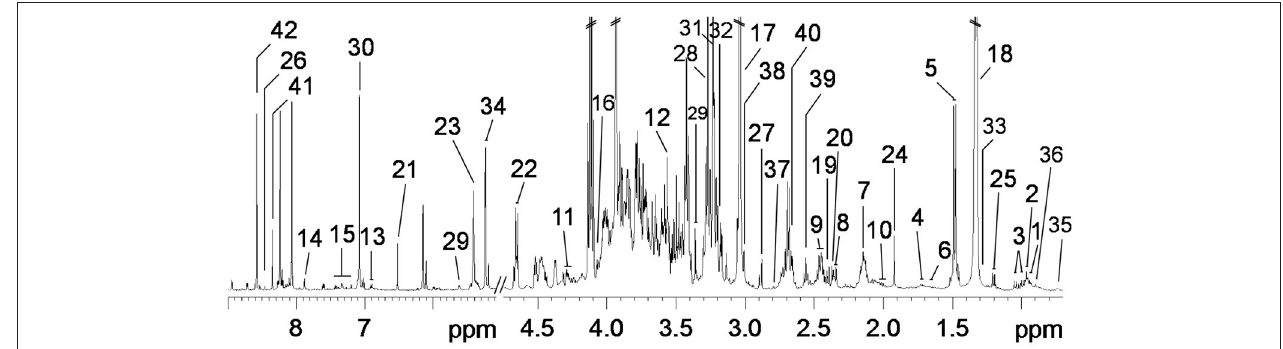
FIGURE 1 | Typical 600-MHz 1 H NMR spectra from psoas major muscle of pigs. A total of 42 metabolites were unambiguously assigned. 1, isoleucine; 2, leucine; 3, valine; 4, lysine; 5, alanine; 6, arginine; 7, methionine; 8, glutamate; 9, glutamine; 10, proline; 11, threonine; 12, glycine; 13, tyrosine; 14, 1-methylhistidine; 15, phenylalanine; 16, creatine; 17, creatinine; 18, lactate; 19, pyruvate; 20, succinate; 21, fumarate; 22, β -glucose; 23, α -glucose; 24, acetate; 25, β -hydroxyisobutyrate; 26, formate; 27, trimethylamine; 28, trimethylamine oxide (TMAO); 29, myo -Inositol; 30, histidine; 31, choline; 32, glycerol-phosphatidylcholine (GPC); 33, lipids (triglycerides and fatty acids); 34, unsaturated lipids; 35, low-density lipoprotein (LDL); 36, very low-density lipoprotein (VLDL); 37, dimethylamine; 38, albumin; 39, α -ketoglutarate; 40, aspartate; 41, guanine; 42,